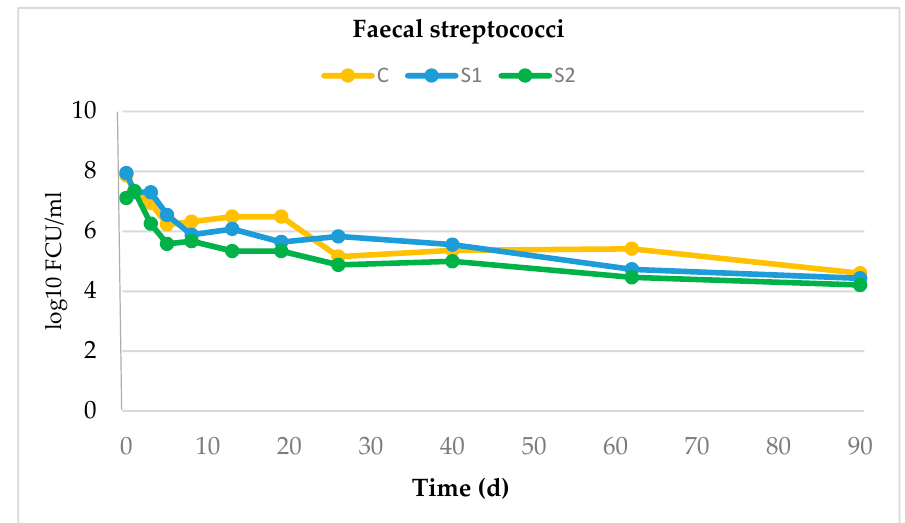
Figure 8. Counts of faecal streptococci during composting.